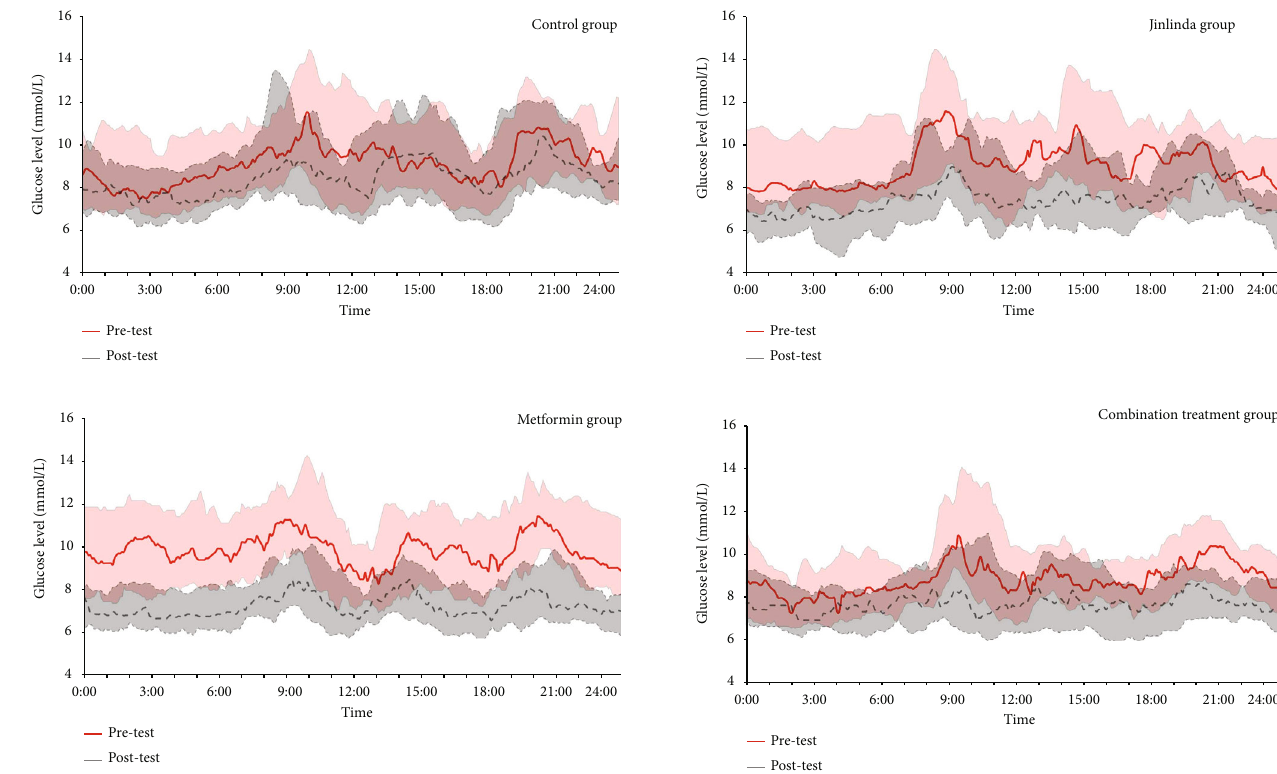
Figure 3: Average continuous glucose-monitoring (CGM) tracings for 72 hours at pre- and post-test. Average CGM values were calculated for each 5 min interval throughout the 3 days for each group.